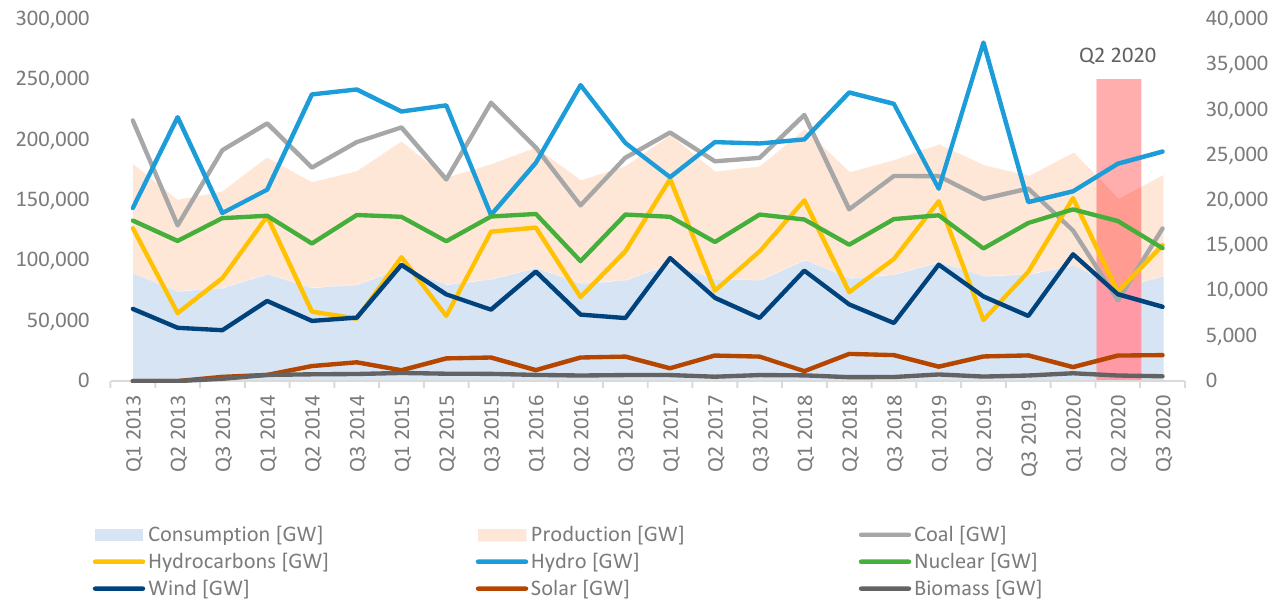
Figure 5. Comparative analysis of generation and consumption of electricity from different fuels in Romania, from Q1, Q2, and Q3 2013–2020. Source: calculation of quarterly production of electricity, from official data [52].